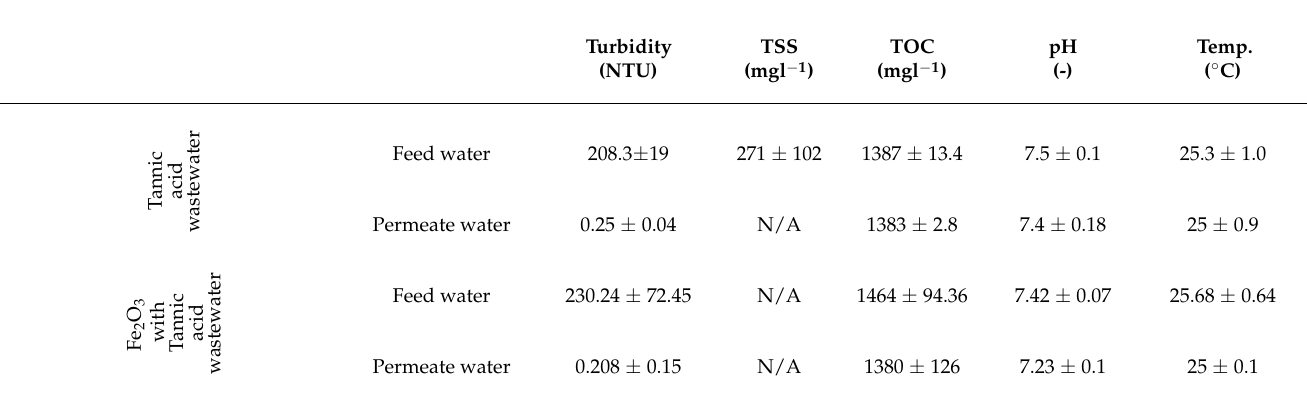
Table A2. Permeate water quality of microfiltration.